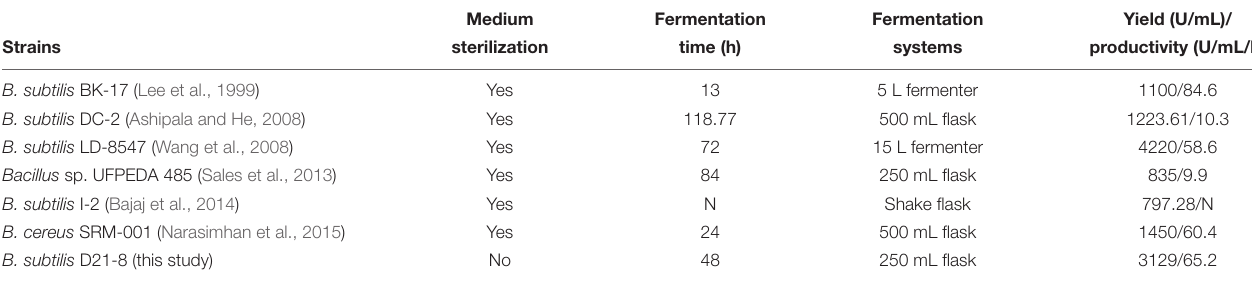
TABLE 3 | Comparison of fibrinolytic enzyme production between B. subtilis D21-8 and other strains by submerged batch fermentation.